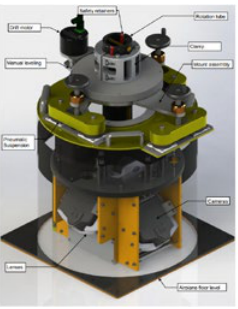
Figure 1. MIDAS 5 system assembly (www.trackair.com). For the images orientation 15 ground control points and 10 tie points derived by the 1:2000 municipal digital map of